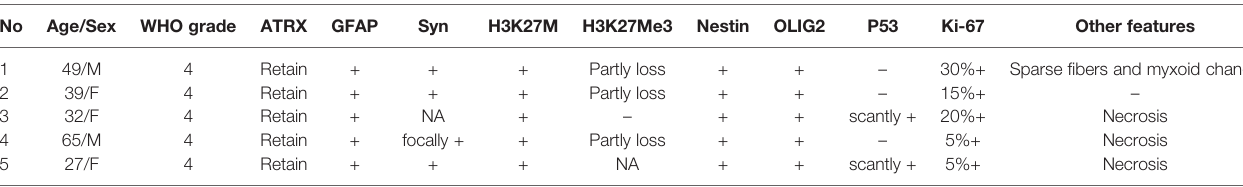
TABLE 2 | Immunohistochemical fi